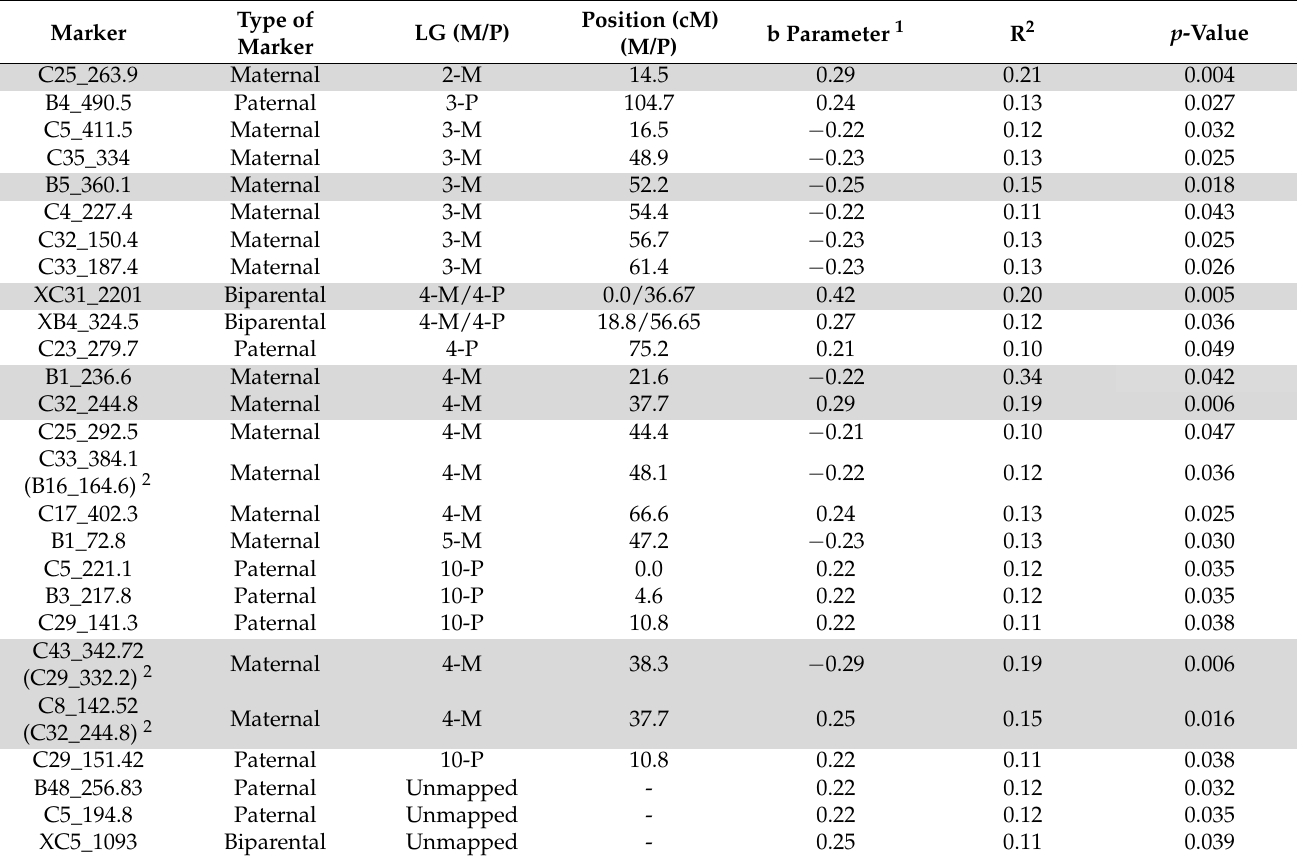
Table 6. Markers significantly associated with apospory expressivity detected in the F 1-C